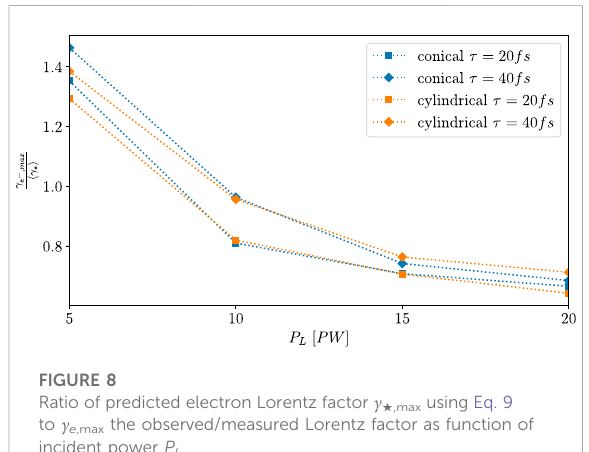
FIGURE 8 Ratio of predicted electron Lorentz factor γ + ,max using Eq. 9 to γ e ,max the observed/measured Lorentz factor as function of incident power P